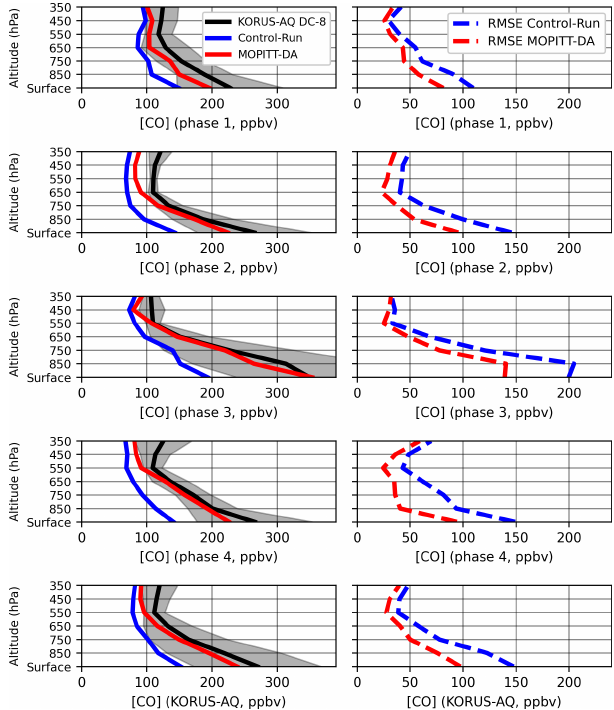
Figure 2. Average CO profiles (left panels) and related RMSE (right panels) for the control run and the MOPITT-DA. The mean (black line) and standard deviation (shaded grey) of the DC-8 observations are calculated for each 100hPa bin. The first four rows are averaged over the different weather regimes of the campaign (Peterson et al., 2019). The last row displays the average over the whole